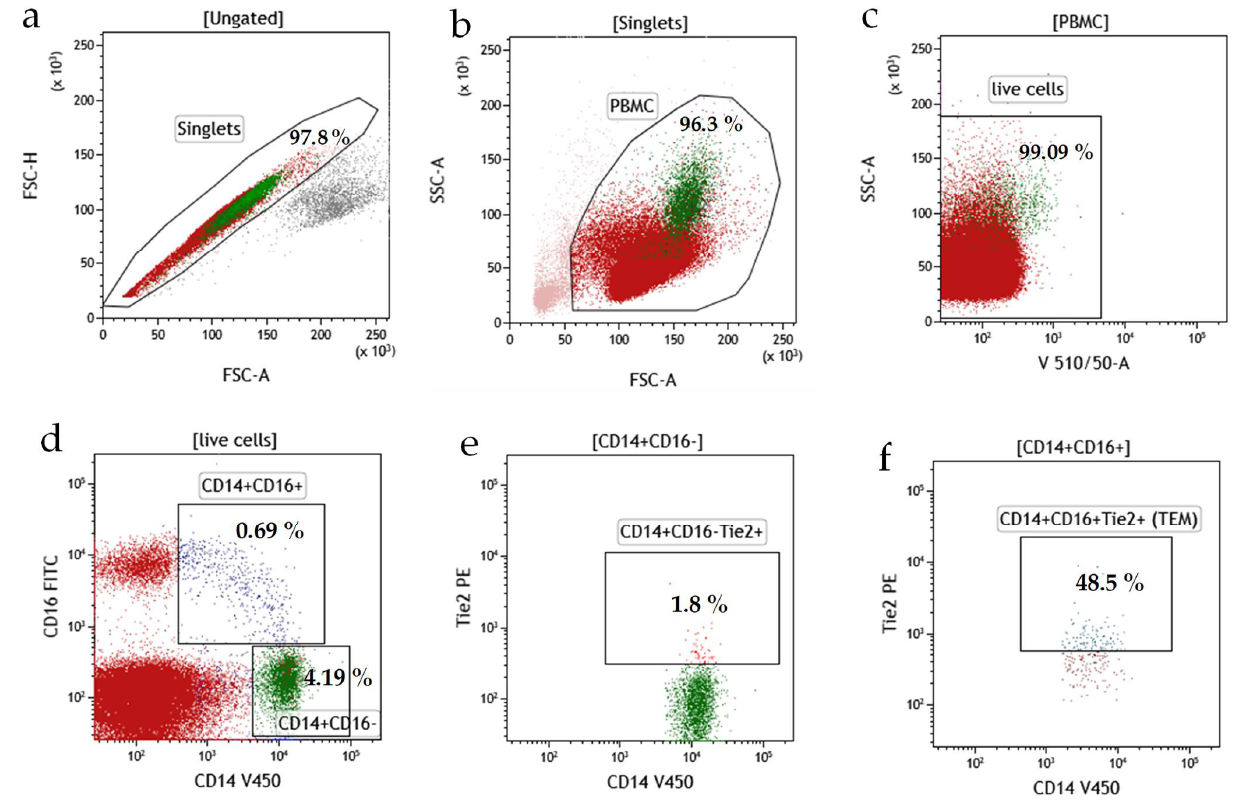
Figure 1. Representative dot plots from a CLL case illustrating the analytic method for the identification of TEMs (CD14+CD16+Tie2+). ( a ) FSC-A vs. FSC-H dot plot: doublets’ discrimination. ( b ) After gating a singlet PBMC were selected based on their SSC/FSC properties. ( c ) Gated events were analyzed for Aqua fluorescent reactive dye staining (LIVE/DEAD Fixable Dead Cell Stain Kit). Discrimination of live and dead cells. ( d ) Gated live cells were analyzed for CD14 V450 and CD16 FITC staining (dot plot: CD14 V450 vs. CD16 FITC). CD16-positive monocytes were gated (CD14+CD16+). CD16-negative monocytes were also analyzed (CD14+CD16−). Selected CD14+CD16+ and CD14+CD16− monocytes were analyzed for Tie2 PE staining. ( e,f ) Final dot plots (CD14 V450 PE vs. Tie2) indicate CD14+CD16− ( e ) and CD14+CD16+ ( f ) monocytes positive for Tie2 expression. TEM were defined as CD14+CD16+Tie2+ cells ( f ). The gate for Tie2+ cells was set based on the FMO control. FMO control contained all fluorochromes in a panel except for Tie2 PE. The FMO control identified any spread of fluorochrome in an unlabeled channel and places the gates in the correct place. Each dot plot shows the input gate in the title. The percentage for each gate was shown. Data were analyzed using Kaluza 2.1.1 software. TEM, Tie-2 expressing monocytes; FSC, forward scatter; SCC side scatter; PBMC, peripheral blood mononuclear cells; FMO, Fluorescence Minus One.